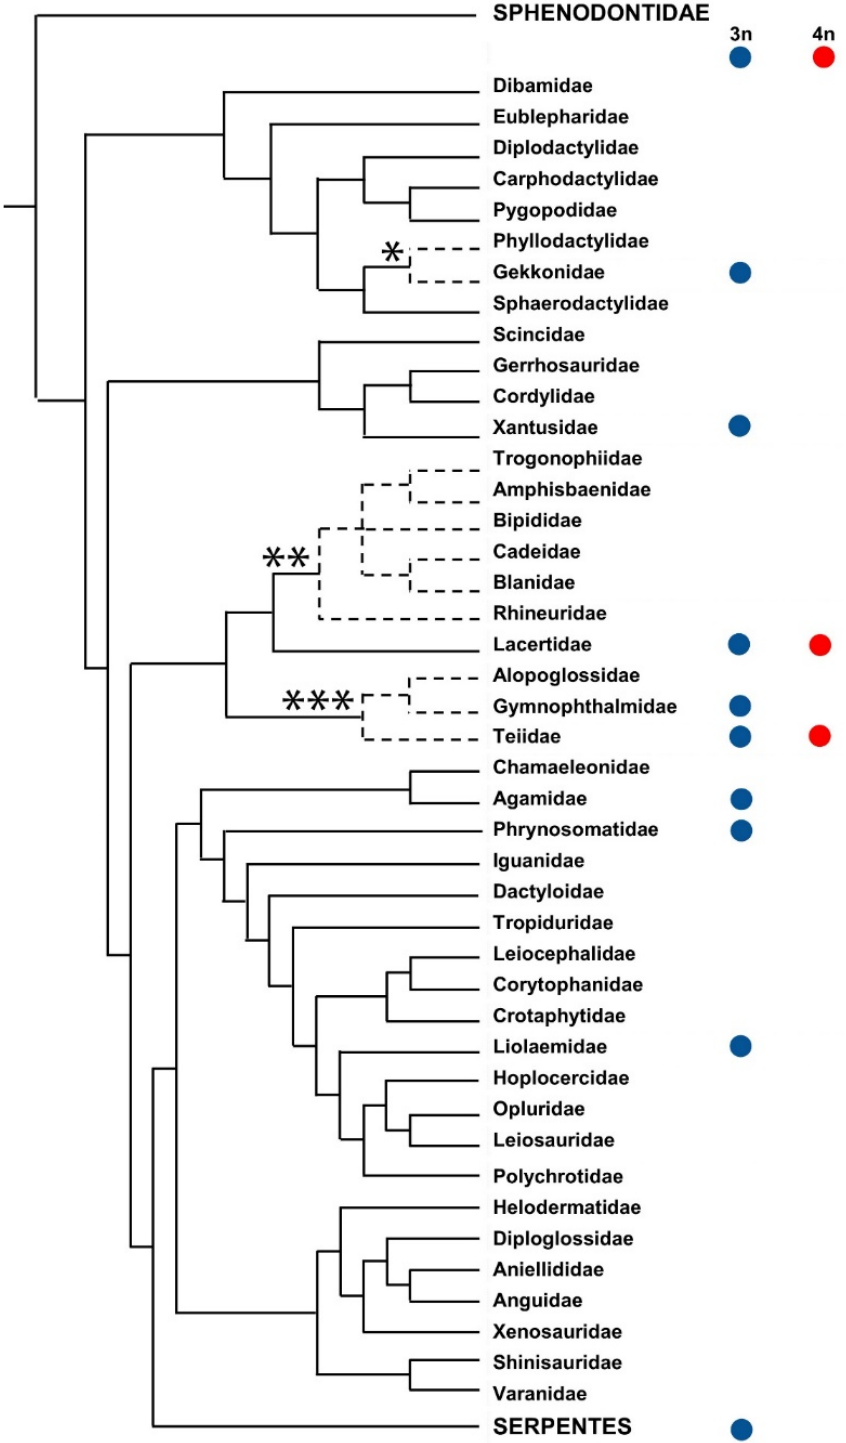
Figure 3. Phylogenetic distribution of polyploidy in squamates. Phylogenetic relationships redrawn from [67]. Dashed lines represent phylogenetic relationships determined by * Gamble et al. [68], ** Vidal and Hedges [69], and *** Hernández-Morales [70]. In snakes, true polyploidy is only known in two species. The brahminy blind snake In- dotyphlops braminus (Typhlopidae) shows a triploid genomic configuration (3n = 42) [76–78] obligate